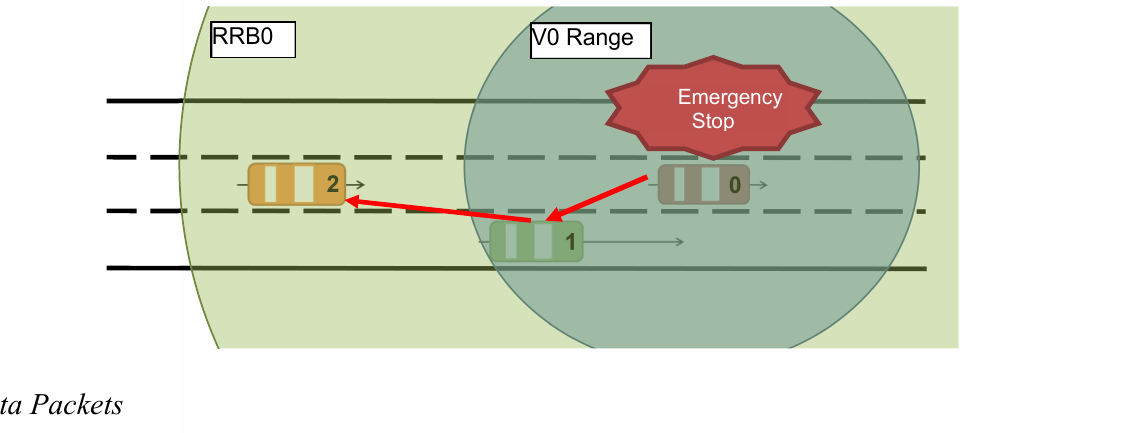
Figure 3. Example of geo-broadcast message flow in an emergency situation. V0, Vehicle 0.